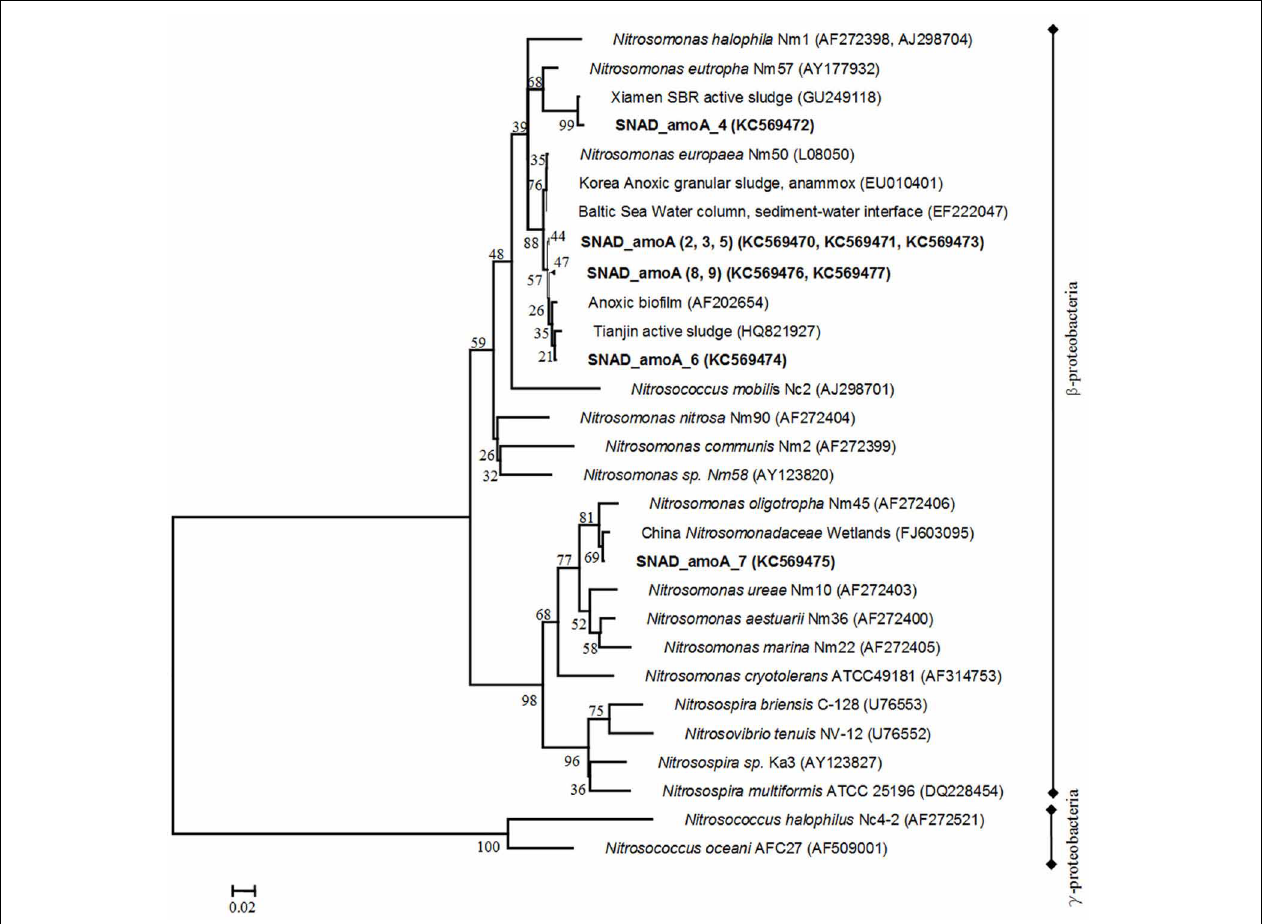
FIGURE 2 | Phylogenetic tree, reflecting amo A gene diversity. Names of AOB are printed in italics and names of clone sequences are printed in bold. The phylogenetic tree was constructed using the Neighbour—Joining method with the Poisson correction model. Distances are in the units of the number of amino acid substitutions